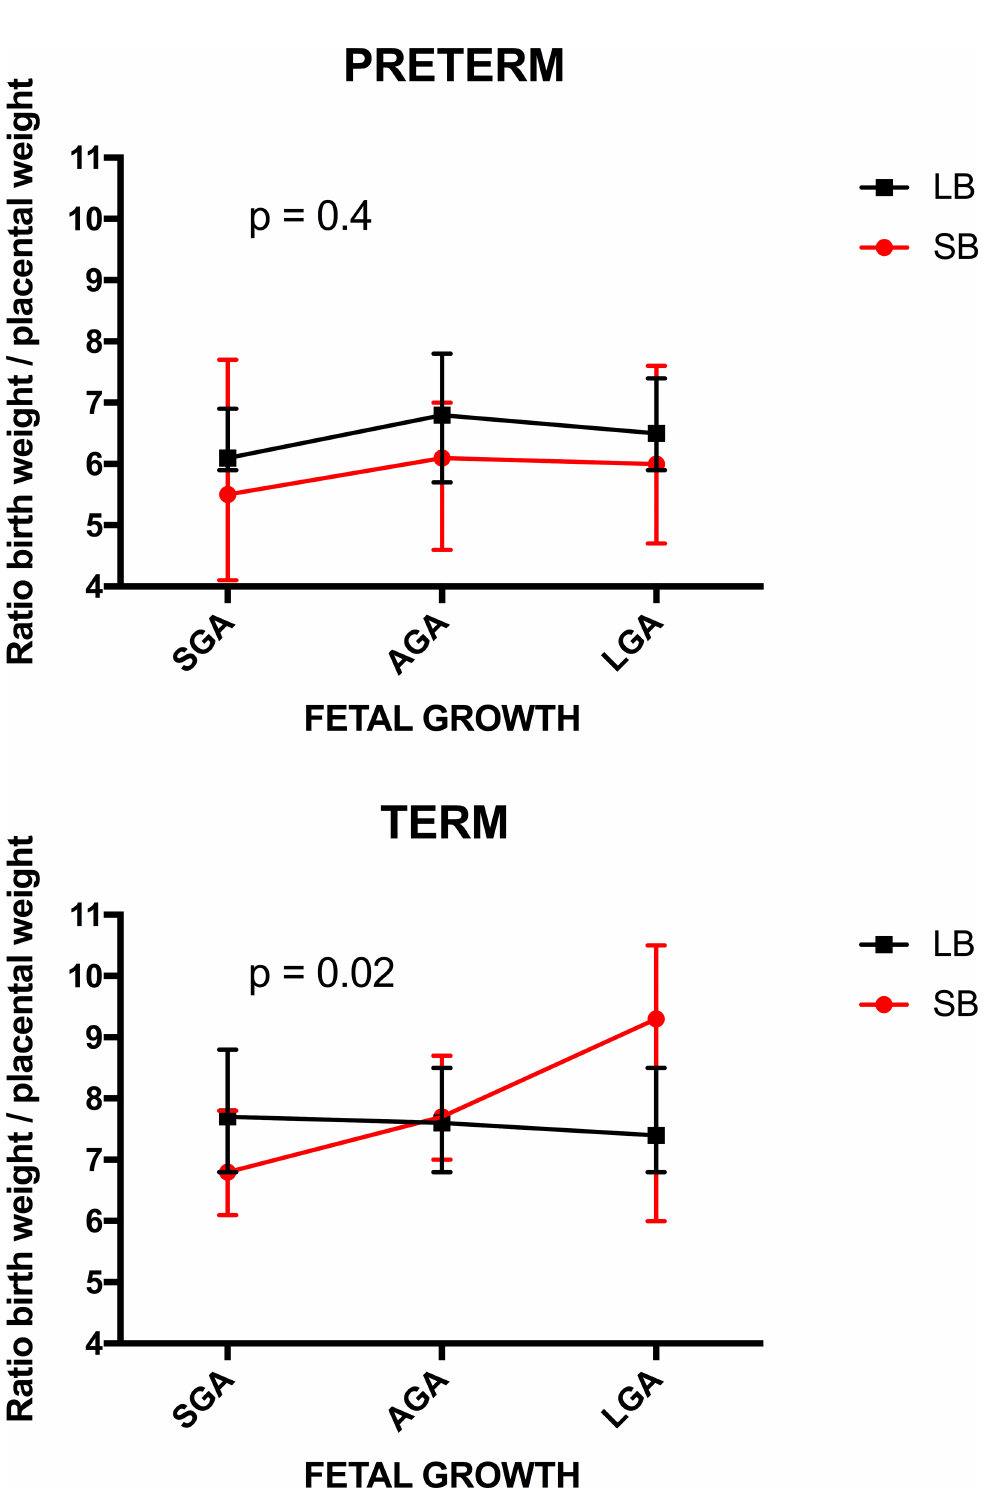
Fig 2. Birth weight to placental weight ratio in preterm and term pregnancies. P-value for a test of whether the association between the ratio and birth weight percentile group differed for stillbirthsand live births after adjustmentfor gestational age is